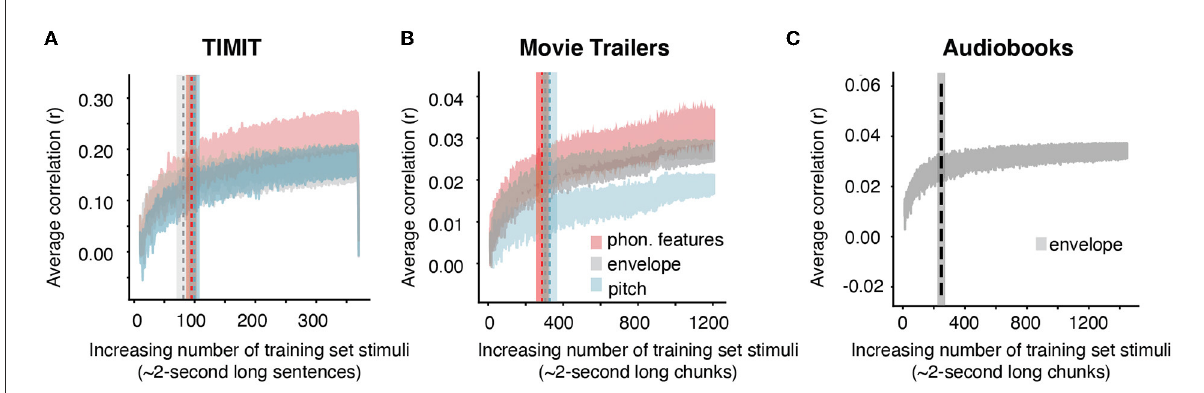
FIGURE2 Average increasing correlation values based on acoustic or linguistic feature selectivity. (A) TIMIT average correlation values with standard error across all 16 EEG subjects for individual speech features (phonological features, envelope, and pitch) are shown as an average across all subjects when TIMIT training set sentences are iteratively added into the model. Dashed vertical lines and shading indicate the knee point and corresponding error bar for each individual model type. Despite different numbers of features and differing model complexity, a similar amount of data was required for each of these models. (B) Same as TIMIT but for movie trailers. Again, the knee point values did not differ significantly across models. (C) Audiobook average correlation across n = 19 EEG subjects using only the acoustic envelope as the feature representation (the pitch and phonological features were not provided in the dataset).